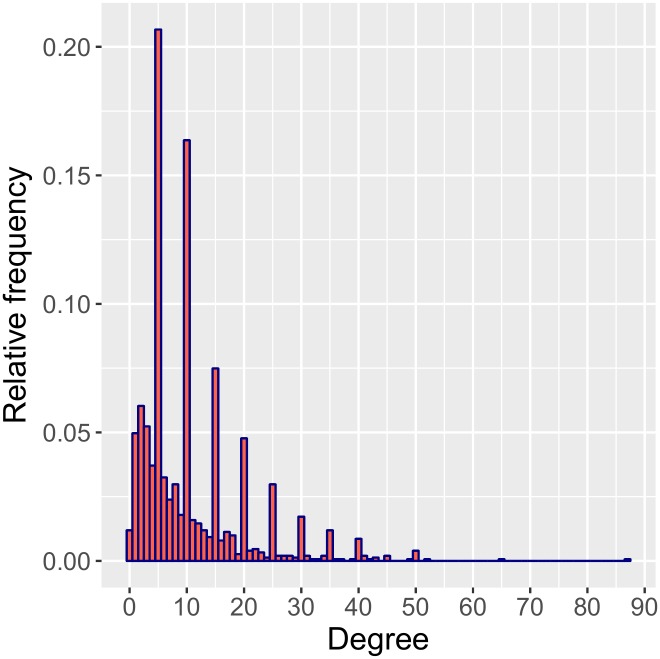
The observed degree distribution for the morning the day before the survey.The spikes result from rounding to multiples of five.